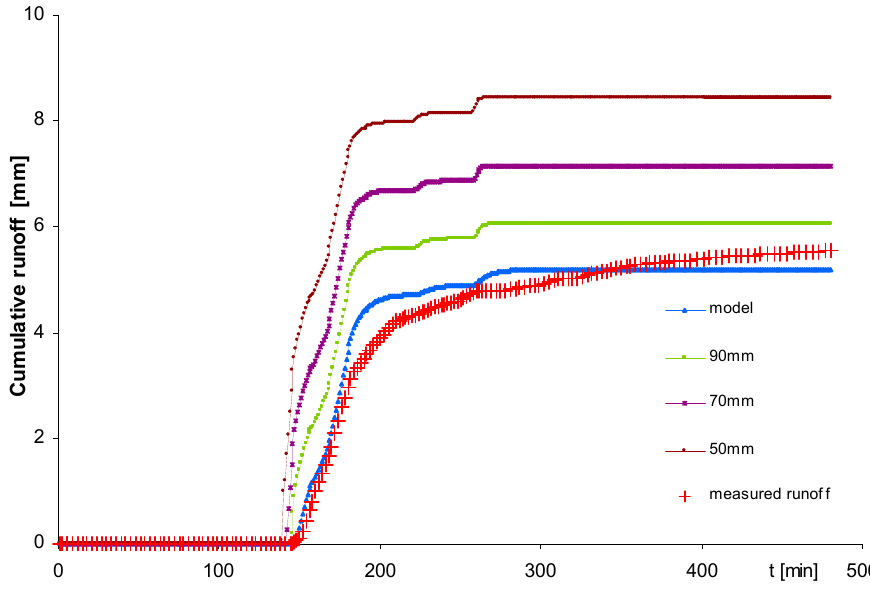
Figure 4. Comparison of measured and simulated cumulative runoff. The effect of increasing the outflow depending on the depth of the zeolite-based vegetation layer (GR1) on 28 July 2017.